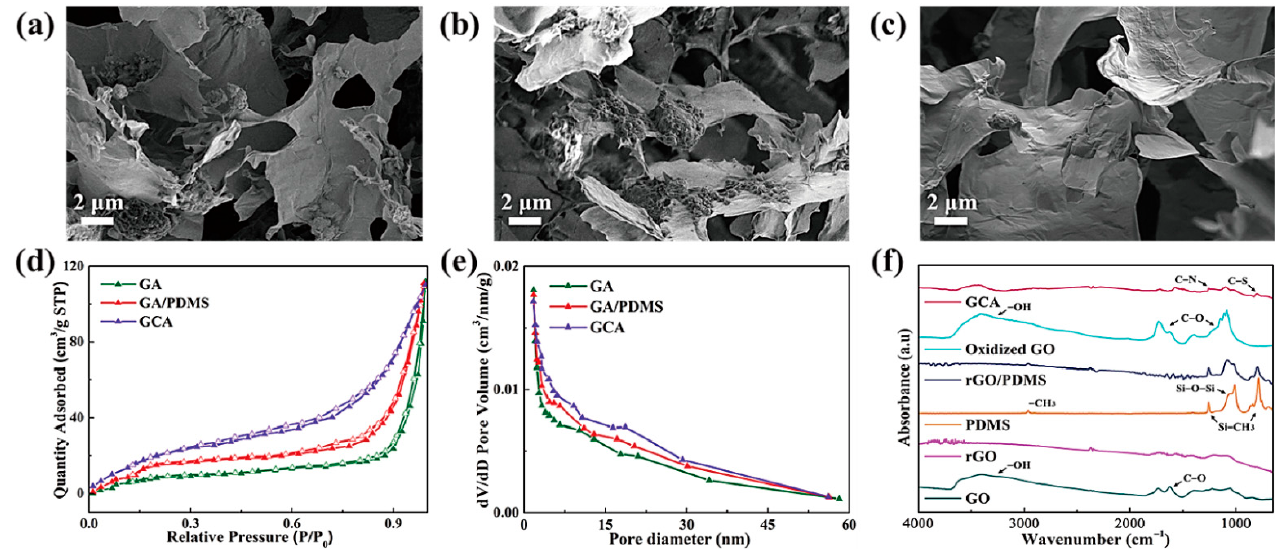
Figure 4. SEM images of ( a ) GA, ( b ) GA/PDMS, and ( c ) GCA. Graphene aerogels BET measurement of ( d ) nitrogen adsorption–desorption peaks, and ( e ) pore size distribution peaks. ( f ) FTIR peaks of the graphene supporting